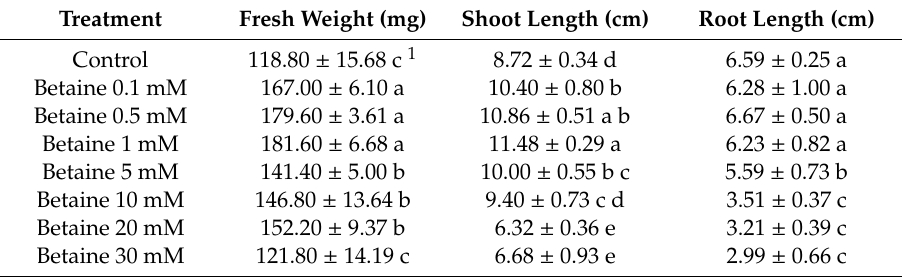
Table 2. E ff ect of betaine hydrochloride treatment on the growth of Tartary buckwheat sprouts. Treatment Fresh Weight